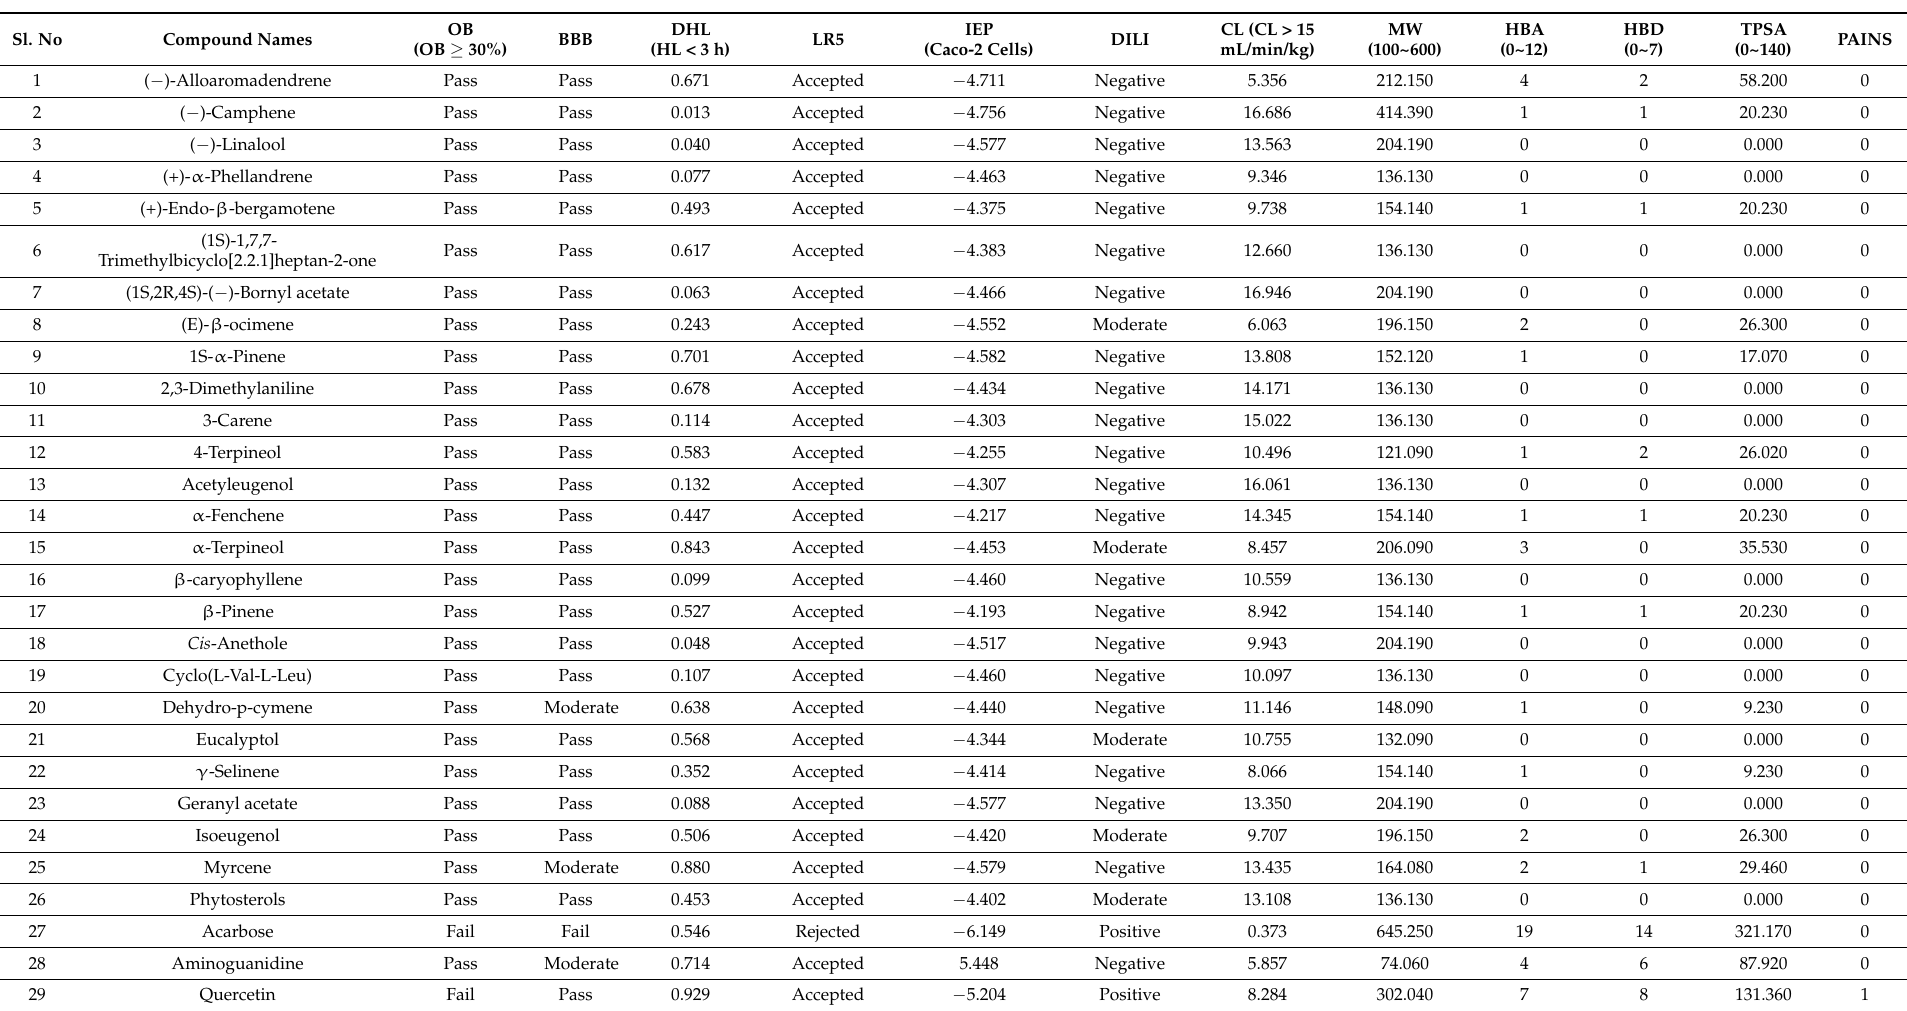
Table 2. Pharmacokinetics and ADMET screening results of selective compounds of O. tenuiflorum obtained from the ADMETlab 2.0